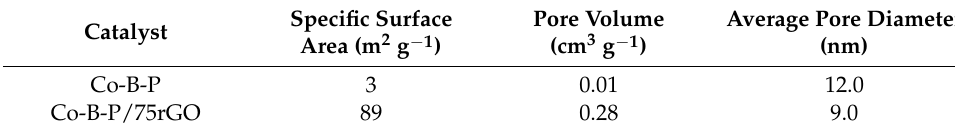
Figure 6. Nitrogen sorption isotherms ( a ) and pore-size distributions ( b ) for the Co-B-P and Co-B- P/75rGO catalysts. Table 1. Textural parameters of the Co-B-P and Co-B-P/75rGO